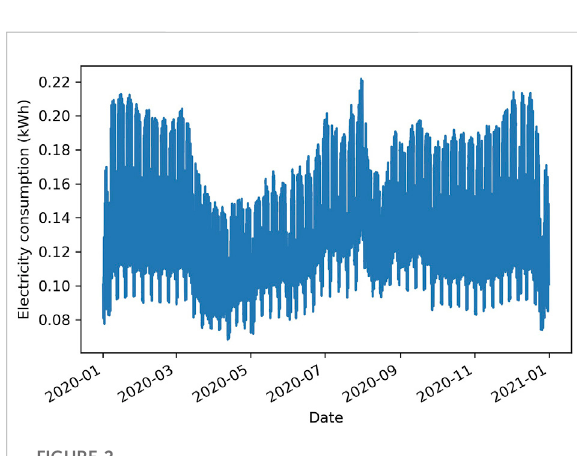
FIGURE 2 Average electricity consumption pro fi le for Italian citizens in kWh from 2020-01-01 to